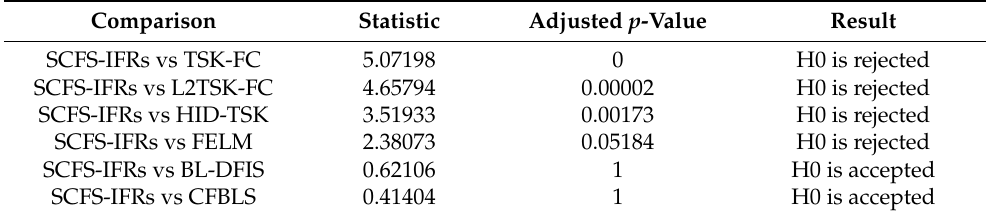
Table 11. Result of Holm post-hoc tests (significance level of